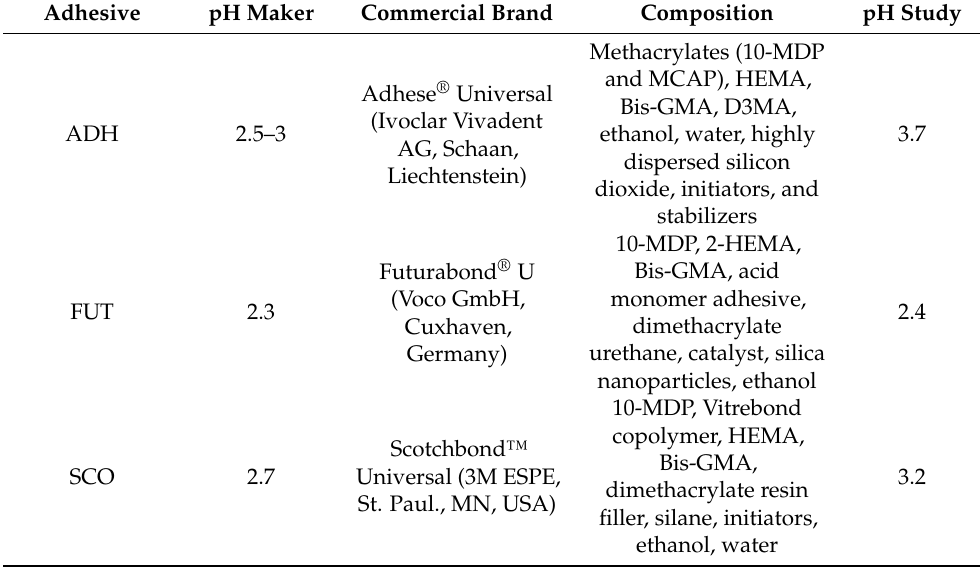
Table 1. Composition and pH of adhesives used.